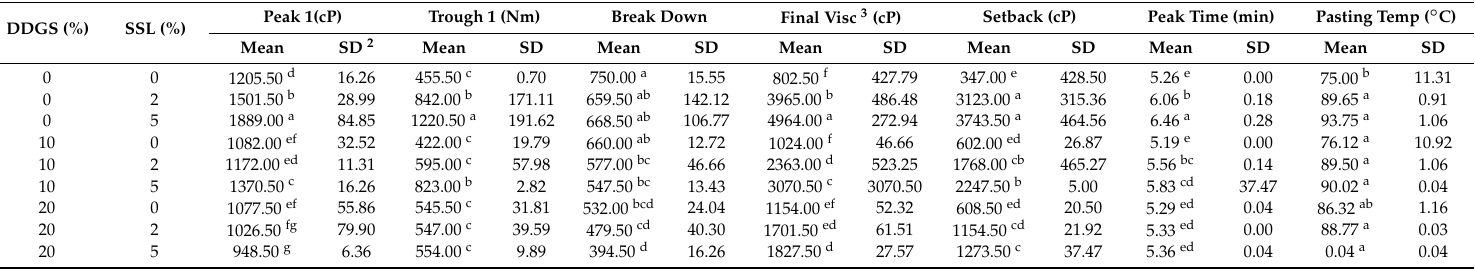
Table 10. Treatment effects on RVA operational parameters 1